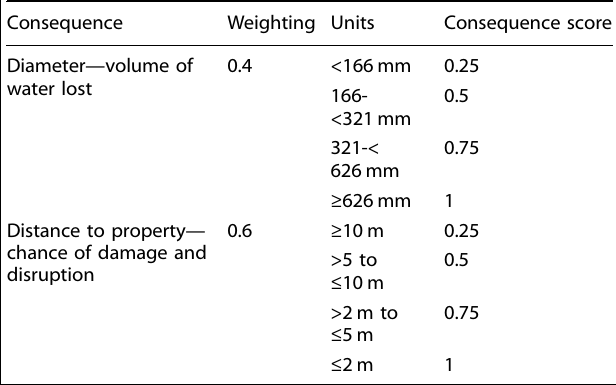
Table 2. Consequences of failure, their weights and associated severity scores.